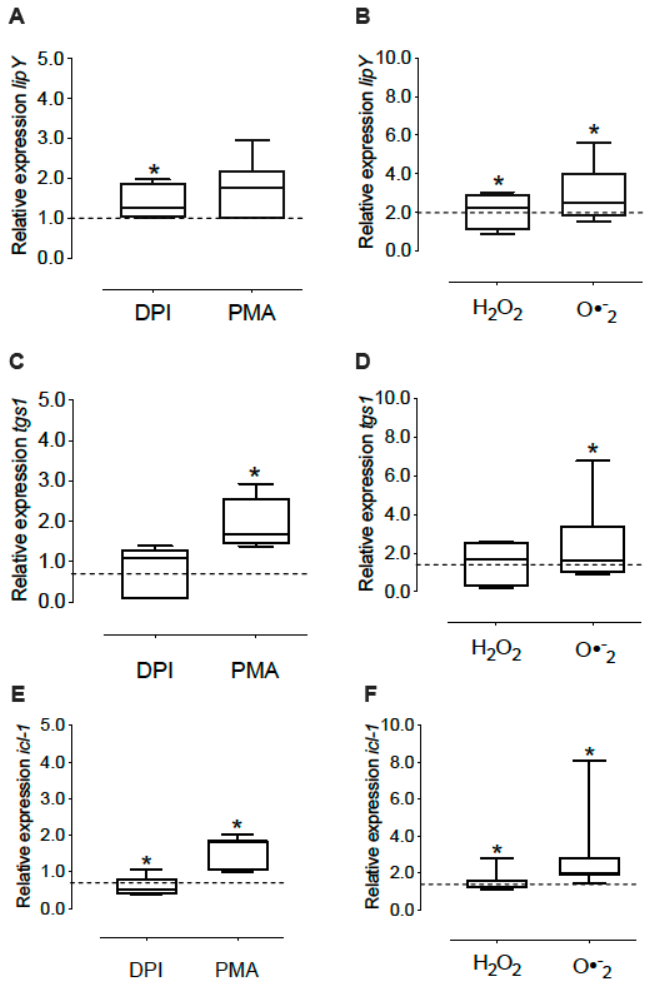
Figure 4. Expression of the lip-Y , tgs-1 and icl-1 in intracellular mycobacteria under oxidant condi- tions. The MDM were treated with NOX modulators (DPI and PMA) for 1 h or oxidizing agents (H 2 O 2 and O 2• − ) for 15 min, and then infected with M. tuberculosis H37Ra (MOI 1:15) in presence of these oxidants for 1 h. Non-phagocyted bacteria were removed, and fresh medium containing NOX modulators or oxidants were added for 2 h. Then, we determined the expression of lip-Y ( A , B ), tgs-1 ( C , D ) and icl-1 ( E , F ). The data show the maximums and minimums by quartiles. * p < 0.05 significant difference compared to intracellular bacteria without treatment (control), n = 7–8. The dashed horizontal line represents the median of the control, and the Wilcoxon test was used to compare against the control (without treatment).